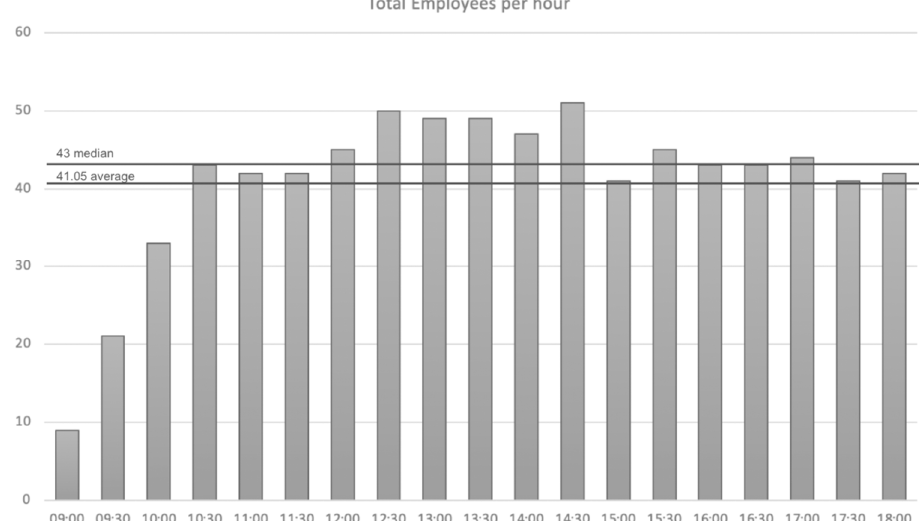
Figure 12. Global occupancy of the workspace (total capacity: 48).